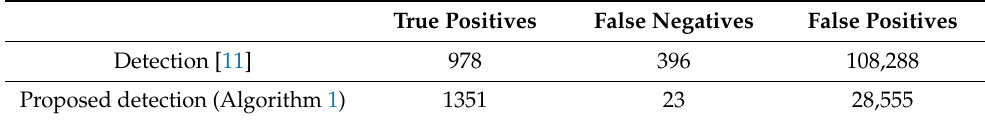
Table 1. Detection on cataloged events for entire period. True Positives False